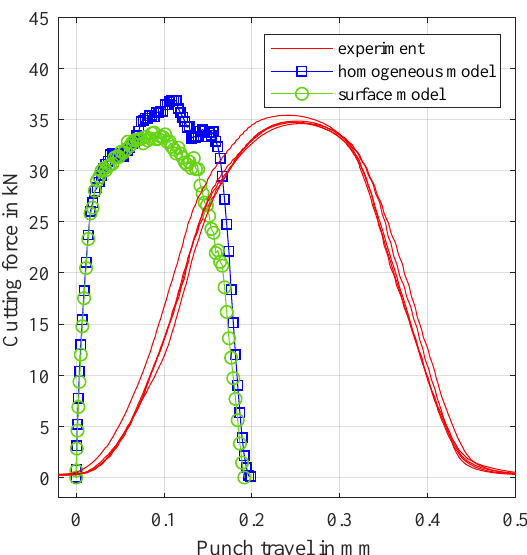
Figure 16. Cutting force over punch travel of the shear cutting experiment as well as of the FEA with surface and homogeneous model